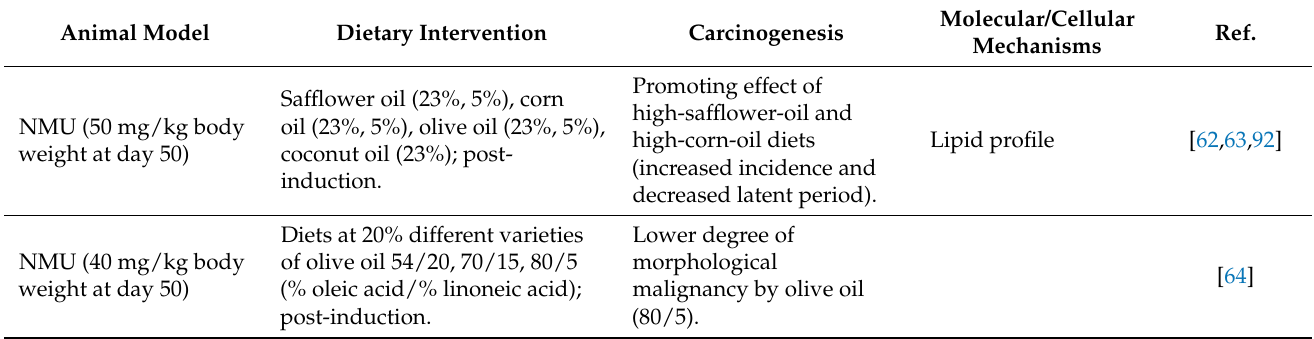
Table 2. Effects and mechanisms of action of olive oil on experimental mammary carcinogenesis. Animal